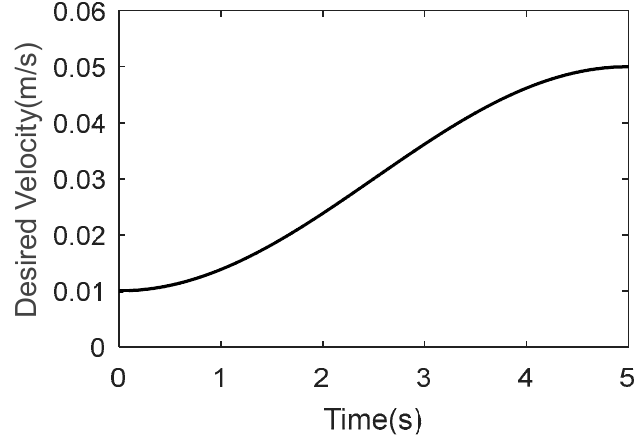
Figure 5. Desired velocity trajectory.